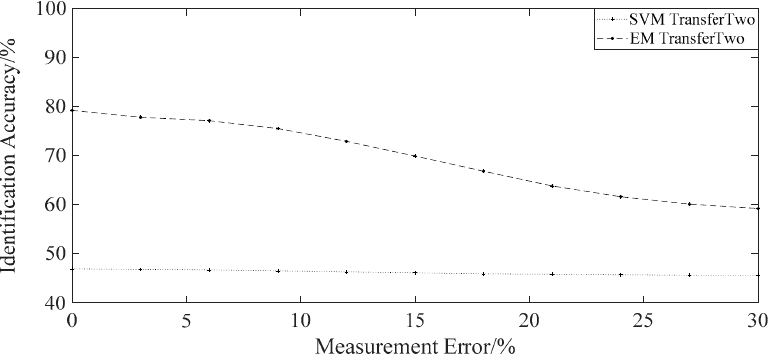
Figure 4. Contrast experiment results in the case where the target domain does not contain labeled